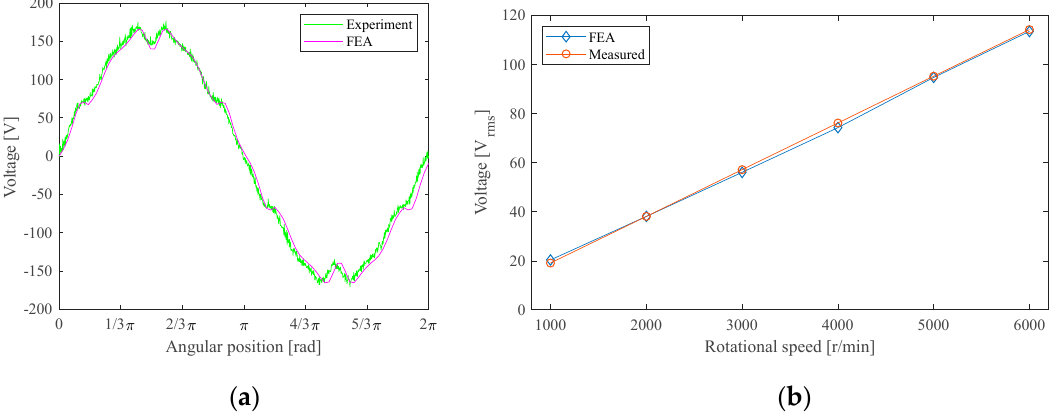
Figure 16. Comparison between FEA results and measured results on back-EMF: ( a ) waveforms of